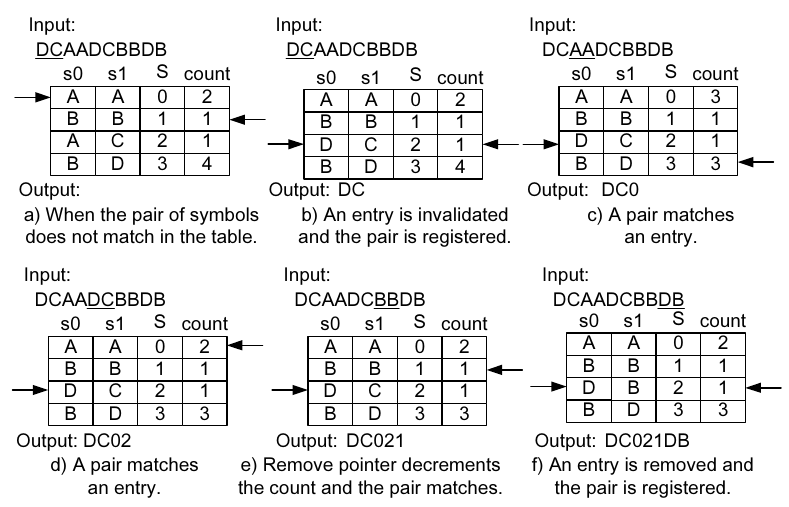
Figure 6. Example of a compression mechanism using the dynamic invalidation.